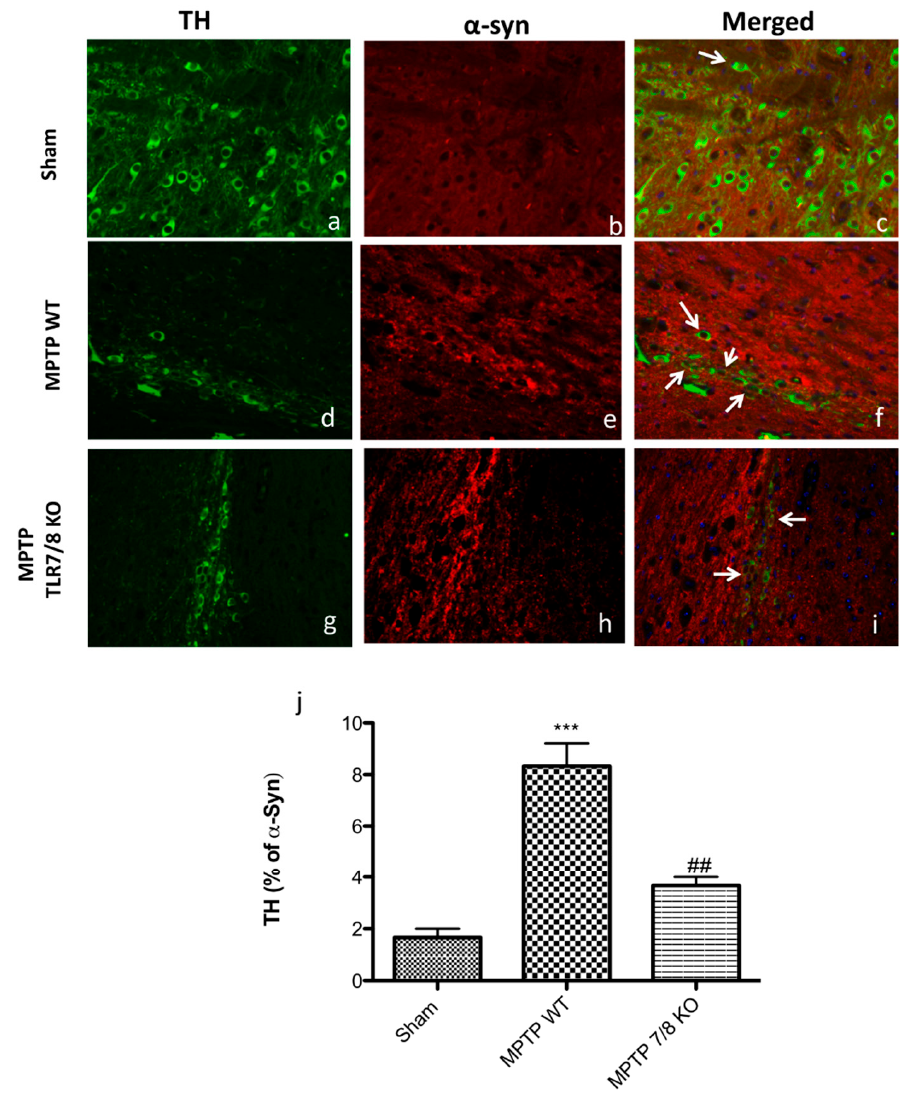
Figure 7. Co-localization of TH / α -synuclein after MPTP-intoxication. Results are shown for SHAM ( a – c ), mice after MPTP-intoxication in WT mice ( d – f ) and after MPTP-intoxication in KO mice ( g – i ) and percentage of TH positive profiles that co-labeled alpha-syn ( j ). Midbrain sections were double stained with antibodies against TH ( a , d , g —green) / α -syn ( b , e , h —red). Midbrain sections revealed an important expression of α -syn in dopaminergic neurons (white arrows) in the MPTP WT mice ( f ; see graphic j ), compared with SHAM group ( b ; see graphic j ). TH / α -syn, double stained (white arrows), was significantly decreased in MPTP TLR7 / 8 KO mice ( i ; see graph j ). The white arrow represents the TH + neurons that co-labeled with α - syn ( c , f , i ). Data are means ± SEM of 10 mice for each group. *** p < 0.001 vs. SHAM WT; ## p < 0.01 vs. MPTP WT.